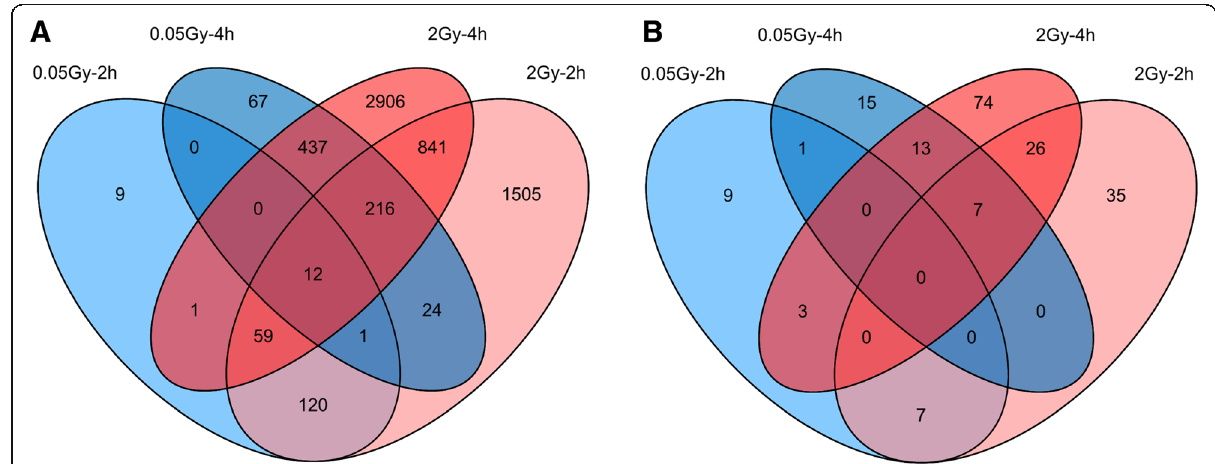
Fig. 1 Differentially expressed genes (DEGs) ( a ) and pathways affected by DEGs (fisher ’ s exact test, p ≤ 0.05) ( b ) in human fibroblasts after exposure to ionizing radiation. a DEGs 2 and 4h after low (0.05 Gray (Gy)) and high dose (2Gy) radiation exposure (adjusted for false discovery rate (<0.05)). b Number of identified pathways in Ingenuity Pathway analysis, where fisher ’ s exact test showed a significant overlap of genes in pathway subset and DEGs ( − log( p -value) ≤ 1.3) but not significant activational prediction (z-score: - 2 ≤ z ≤